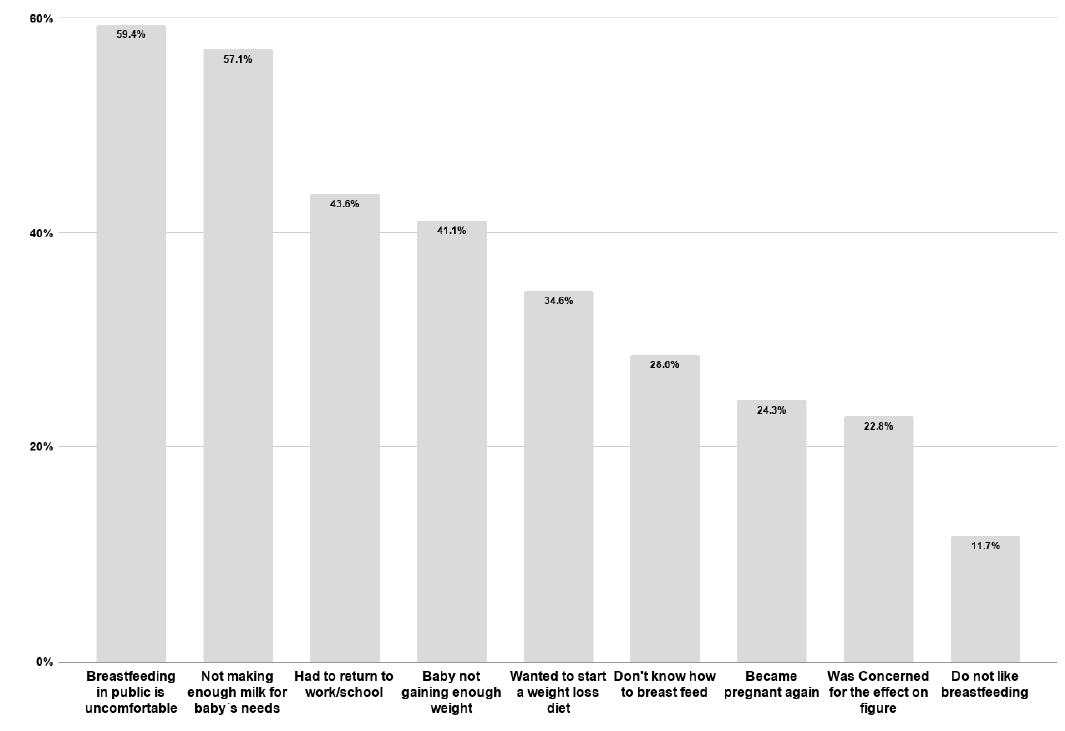
Figure 2. Barriers to continued breastfeeding as identified by mothers attending the PHCC.